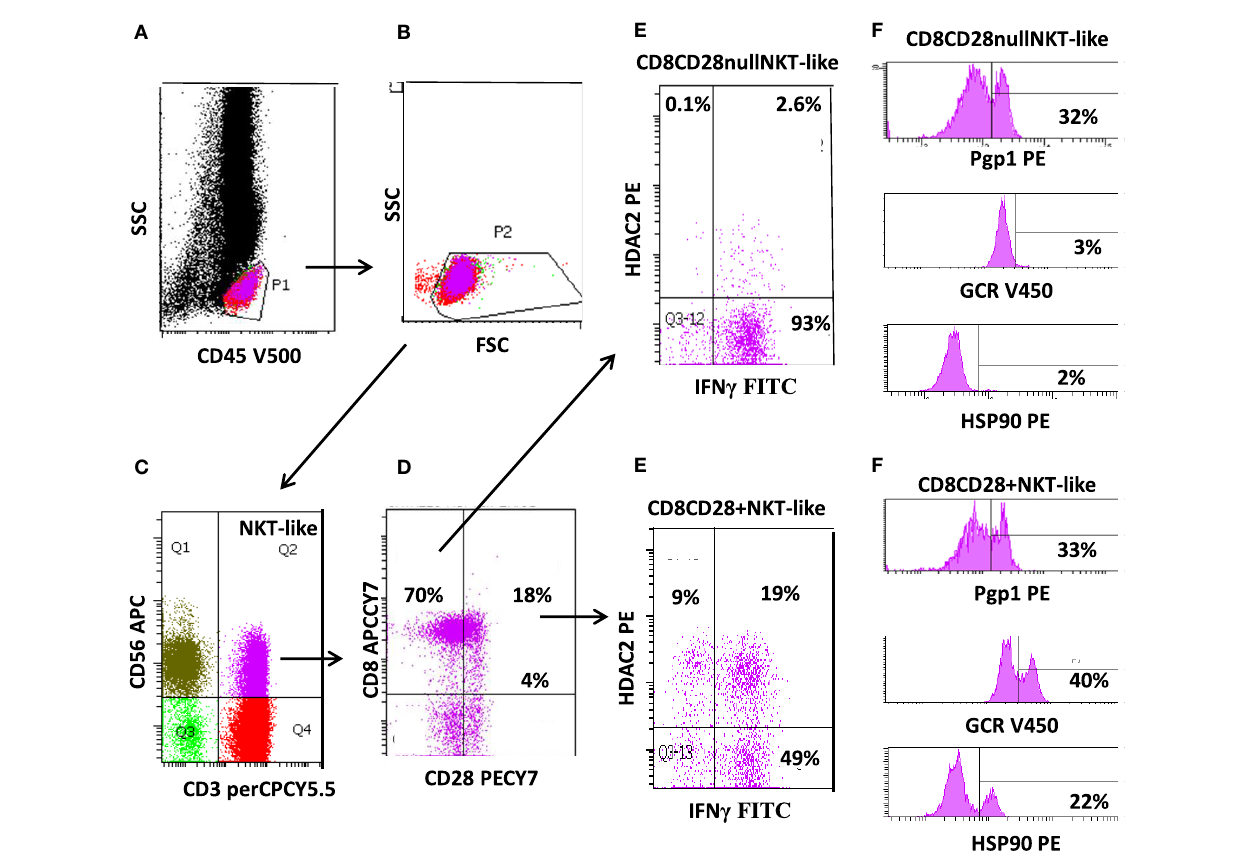
FigURe 1 | Flow cytometric gating technique used to identify CD8 + CD28 null natural killer T-like (nKT-like) cells (and CD8 + CD28 + nKT-like cells) from the peripheral blood of patients with chronic obstructive pulmonary disease . (A) Identification of lymphocytes as CD45 + low side scatter (SSC) events. (B) Removal of red blood cell contaminations removed by lymphocyte gating using forward scatter vs. SSC characteristics. (C) Identification of NKT-like cells as CD3 + CD56 + events. (D) Identification of CD28 null and CD28 + NKT-like cells using CD8 vs. CD28 staining. (e) Expression of IFN γ and histone deacetylase (HDAC)2 in CD8 + CD28 null and CD8 + CD28 + cells. (F) Expression of P-glycoprotein-1 (Pgp1), glucocorticoid receptor (GCR), and heat shock protein (Hsp)90 expression in CD8 + CD28 null and CD8 + CD28 + cells. Note: the majority of NKT-like cells are CD8 + and CD28 null . These cells express reduced HDAC2, GCR, and Hsp90 but increased IFN γ compared with CD8 + CD28 + NKT-like cells (Pgp1